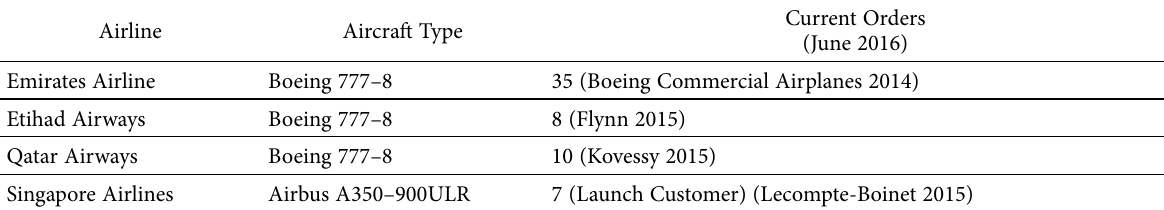
Table 2. Future orders for new ULR-capable aircraft